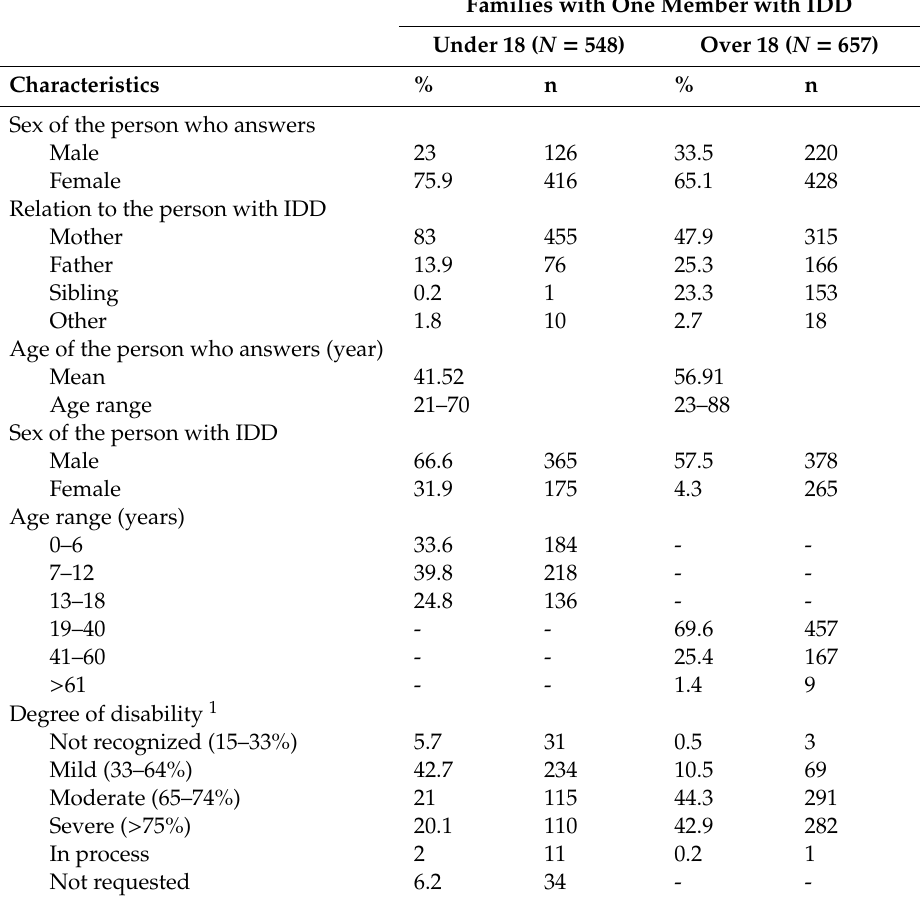
Table 1. Demographic characteristics of the family members who answer the scale and the person with intellectual and developmental disabilities